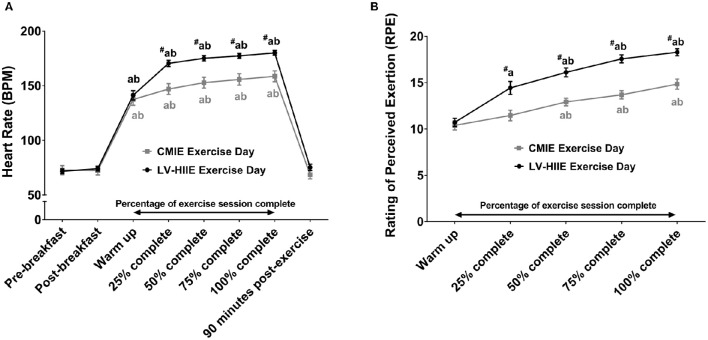
Rating of perceived exertion and heart rate response to LV-HIIE and CMIE. Heart rate (A) and rating of perceived exertion (B) during exercise for both LV-HIIE and CMIE. ap < 0.05 compared to pre-breakfast or warm up; bp < 0.05 compared to 1-h post-breakfast or repetition 2 (25% of CMIE); #p < 0.05 compared to the corresponding time point in the CMIE group. CMIE, continuous moderate intensity exercise; LV-HIIE, low-volume high-intensity interval exercise. Values are means ± SEM.